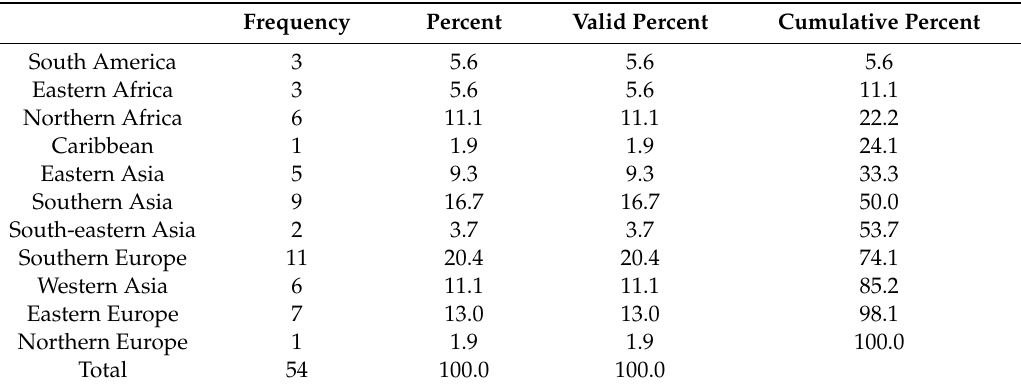
Table 4. Geographical regions of origin for LMIC(low- and middle-income countries)